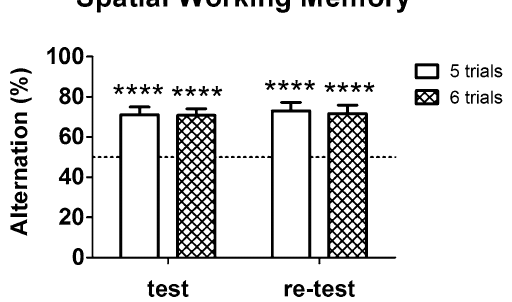
Figure 2. Spatial working memory of healthy wild-type mice in spontaneous alternation T-maze. Percentage of alternation within the first 5 trials (empty bar) and within the first 6 trials (striped bar) were significantly above chance level in both the test and the re-test (for all: p < 0.0001). Asterisks highlight significant differences versus chance level (**** p < 0.0001). Dashed line represents the 50% chance level. Data are presented as mean + SEM (n =